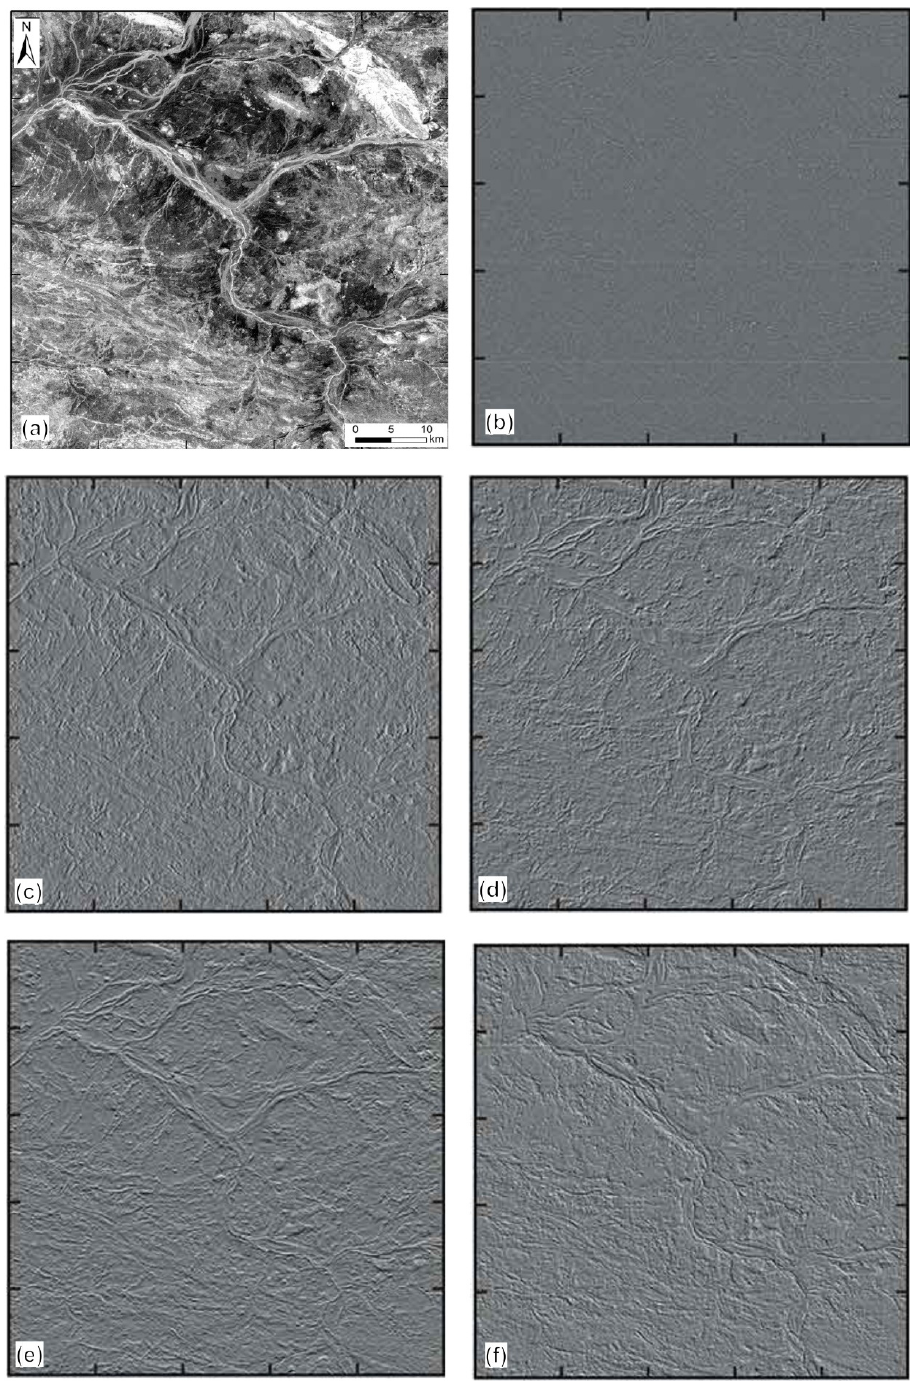
Figure 6. A distinct example of applying the Laplacian and directional filters on the output of MNF derived from Landsat 8 OLI/TIRS over the Yinnietharra area, Western Australia modified from [79]; ( a ) Output of MNF as input for filtering, ( b ) Laplacian filtered image, ( c ) directional filtered image with azimuth 0 ◦ , ( d ) directional filtered image with azimuth 45 ◦ , ( e ) output of directional filtering with an azimuth of 90 ◦ , and ( f ) directional filtered image with an azimuth of 135 ◦